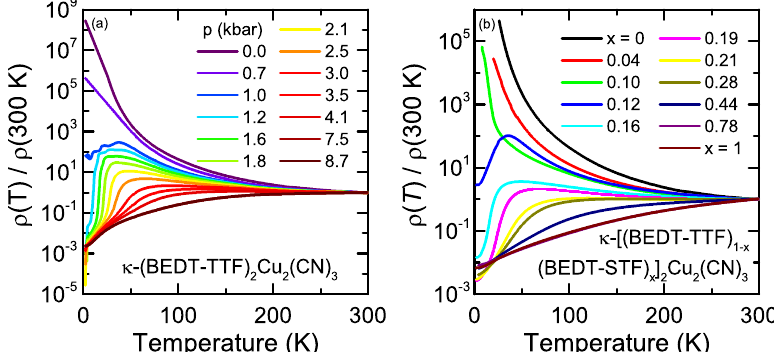
Figure 3. ( a ) Temperature-dependence of the DC resistivity of κ -(BEDT-TTF) 2 Cu 2 (CN) 3 measured within the highly conducting bc -plane when applying hydrostatic pressure. The pressure drop upon cooling was monitored in situ; here, we indicate the values near T = 0. ( b ) Temperature-dependent resistivity of κ -[(BEDT-TTF) 1 − x (BEDT-STF) x ] 2 Cu 2 (CN) 3 where, in the inner rings of the BEDT-TTF molecules, sulfur was partially substituted by selenium. ρ ( T ) is normalized to room